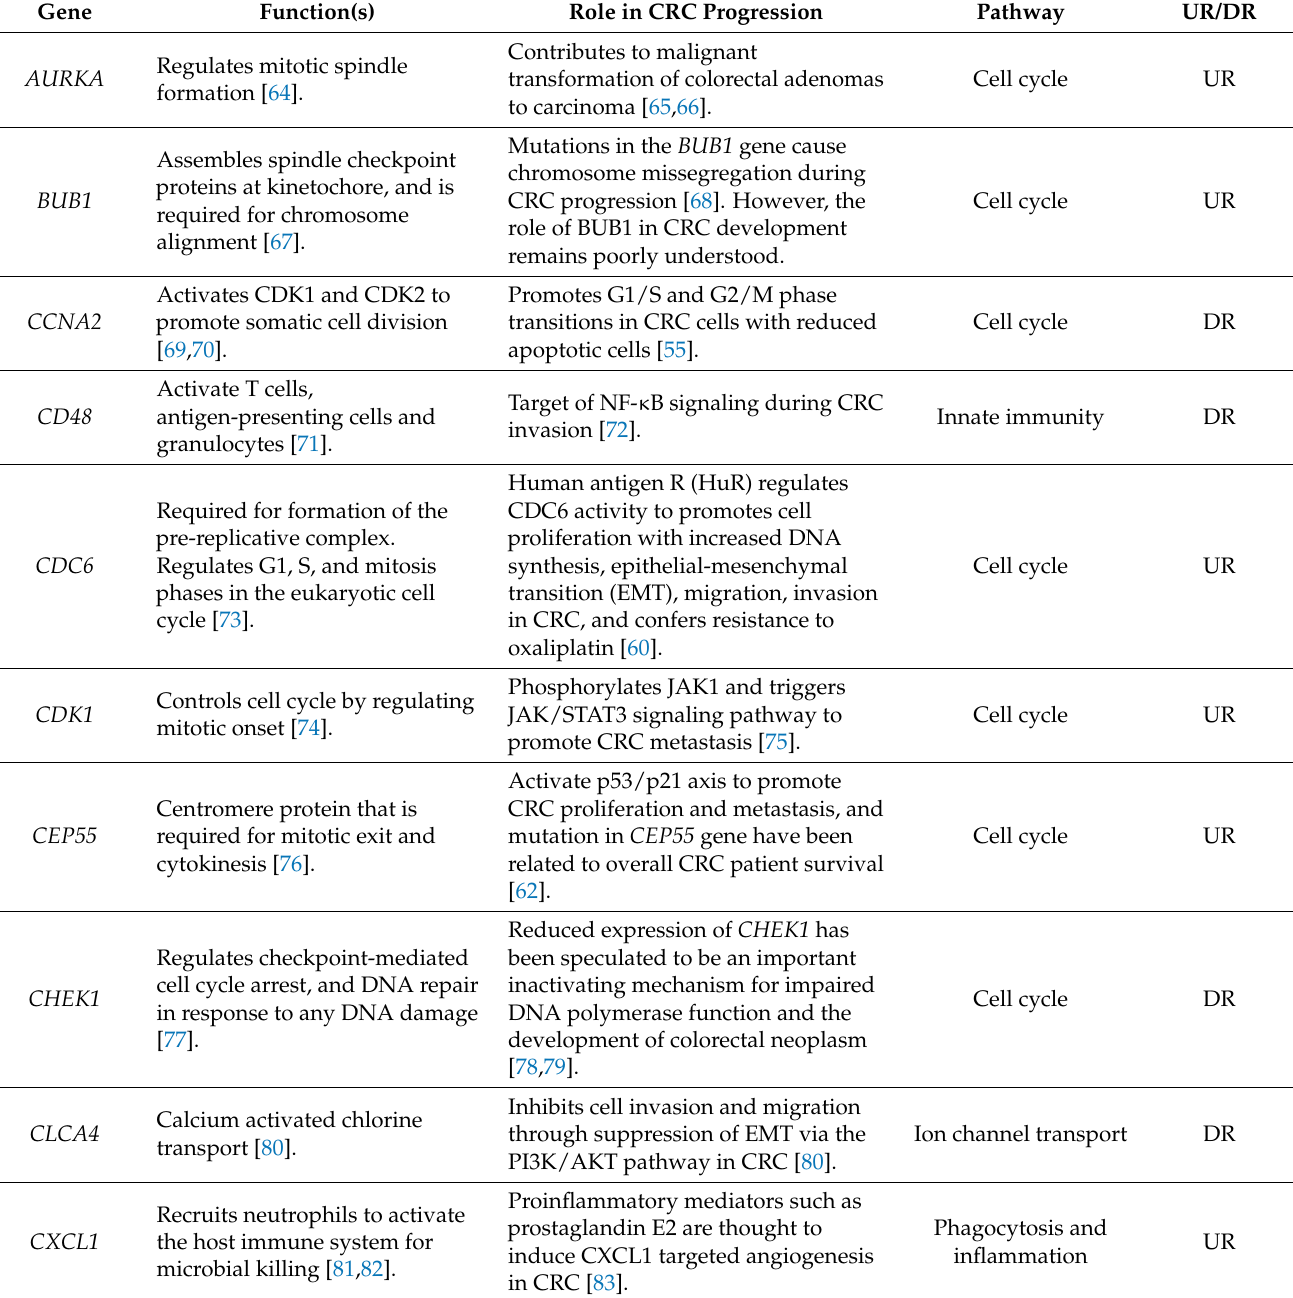
Table 1. Differentially expressed genes during CRC